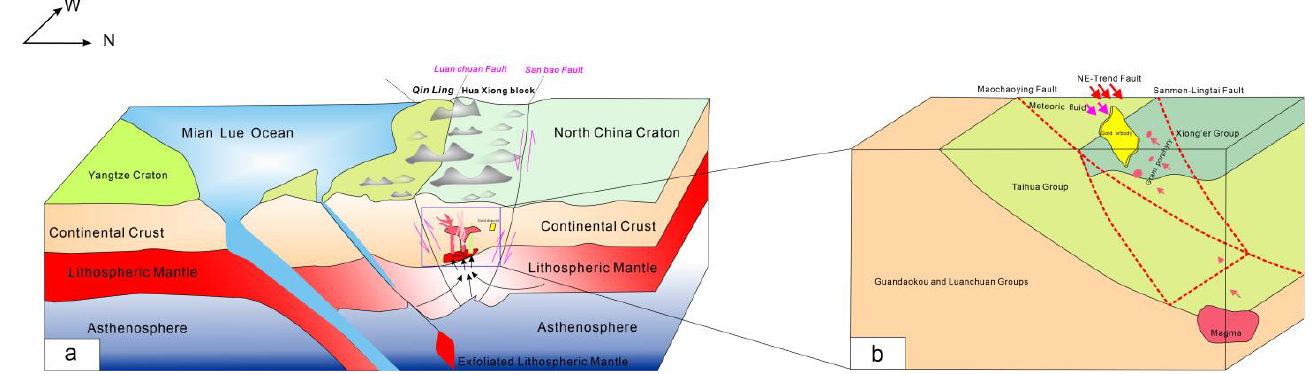
Figure 2. Metallogenic model map of Xiong’er shan gold district: ( a ) Late Mesozoic tectonic-magmatic evolution scenario in Xiong’er shan Area; and ( b ) metallogenic model for the Au polymetallic deposits in Xiong’ershan Area (Modified after [139,140]).